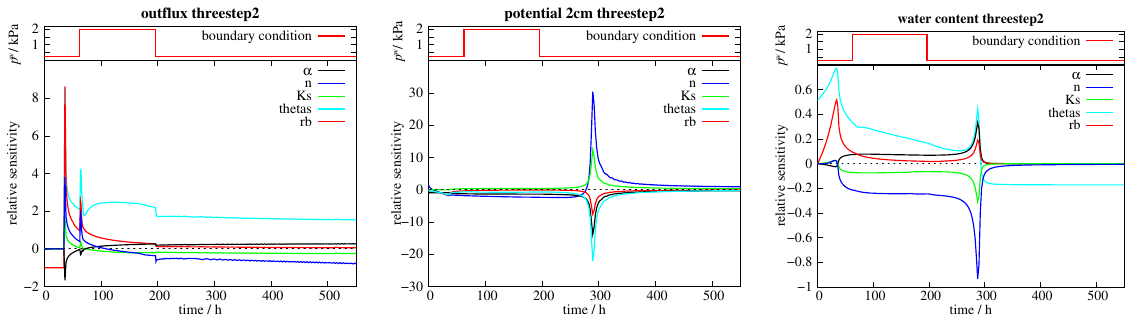
Fig. 9. Sensitivity coefficients s(t) for the threestep experiment for the outflux (left), the potential in 2cm (middle) and the water content in 2cm (right). Notice that p w jumps from equilibrium to 0.25kPa at t =